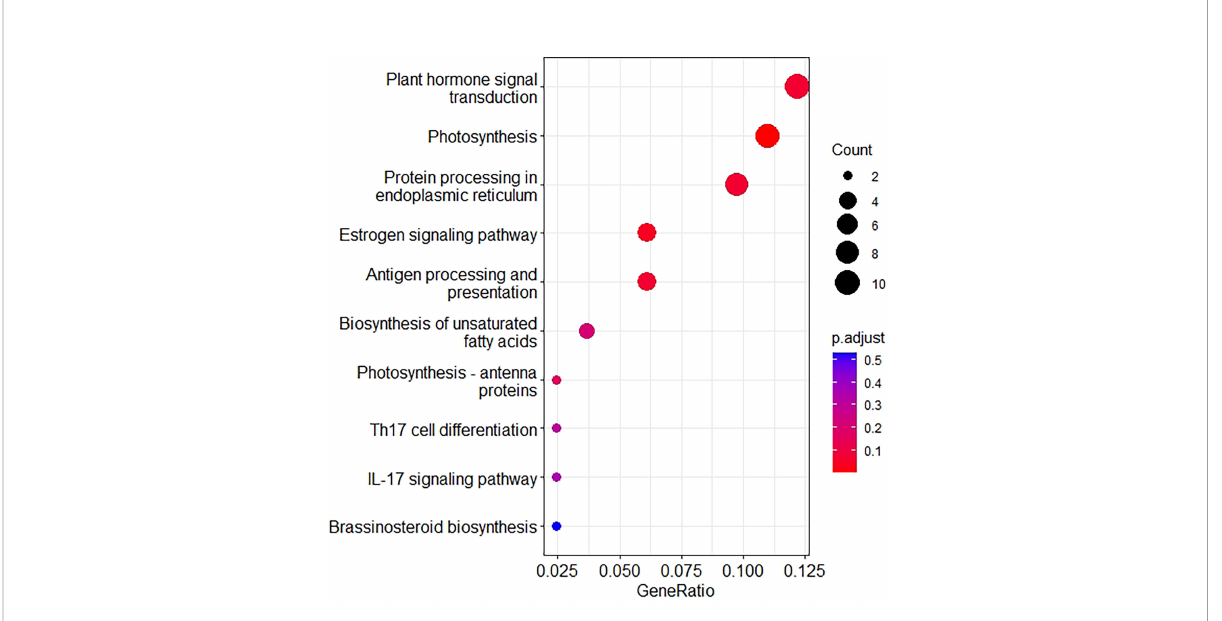
FIGURE 2 KEGG enrichment analysis of DEGs from loss-of-function AUX1 of foxtail